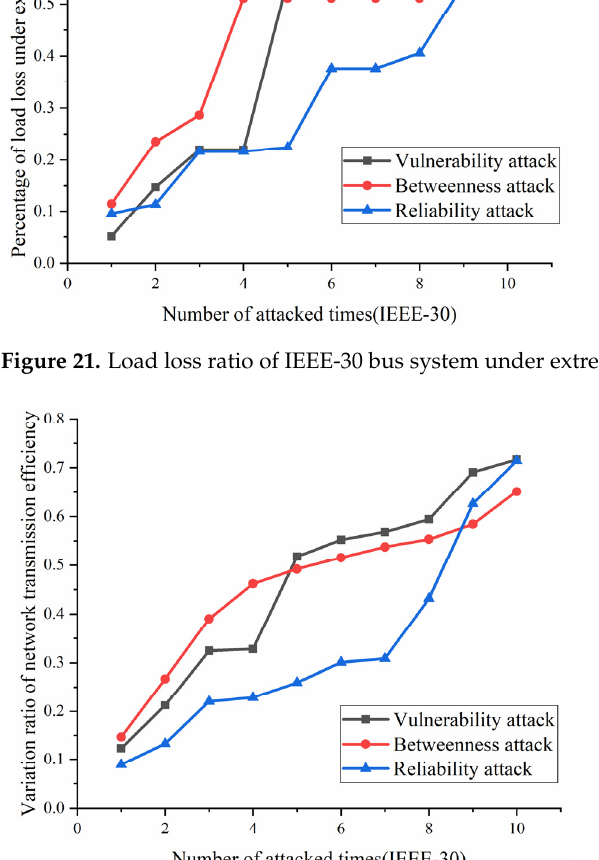
Figure 24. Variation ratio of network transmission efficiency of IEEE-118 bus system under extreme weather. 5.2.3. Structural Vulnerability Result Analysis by Comparing IEEE-30 with IEEE-118 Here, this paper proposes rates of indexes in IEEE-118 divided by indexes in IEEE-30 with the number of attacked times from 1 to 10. Thus, it is much easier to see the difference of results between the two examples. The results in Figure 25 show that the percentage of load loss of IEEE-118 is clearly much smaller than the percentage of load loss of IEEE-30, proving that bigger network IEEE-118 usually is more stable and reliable than the IEEE- 30. On the contrary, in Figure 26, due to more lines and nodes need to be traverse, the variation ratio of transmission efficiency of IEEE-118 is obviously much higher than the ratio of IEEE-30, which suggests that the transmission efficiency in IEEE-118 is much more unstable. The reason why IEEE-118 is not stable in transmission efficiency is that it holds more nodes and lines. Hence, if a line or node is removed, the influenced nodes and lines are much more than the influenced nodes and lines in IEEE-30.